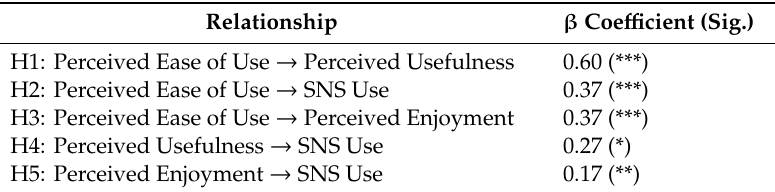
Table 4. Relationship by β coe ffi cients. Relationship